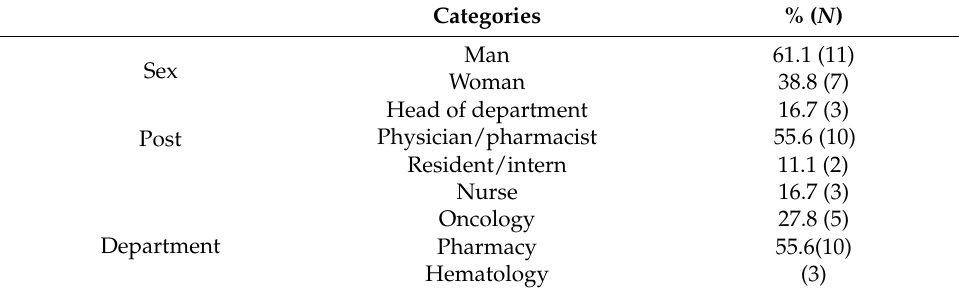
Table 2. Professionals taking part in Nominal Group ( N =